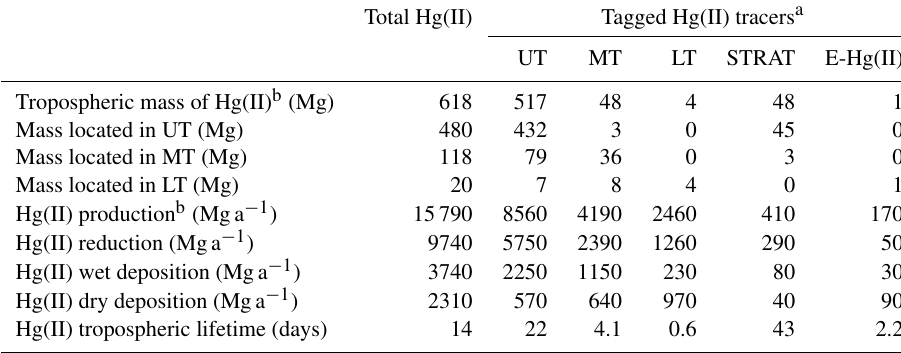
a Regions are defined as follows: UT (upper troposphere: 400hPa – tropopause), MT (middle troposphere: 750–400hPa), LT (lower troposphere: surface – 750hPa), STRAT (stratosphere), and E-Hg(II) (directly emitted anthropogenic